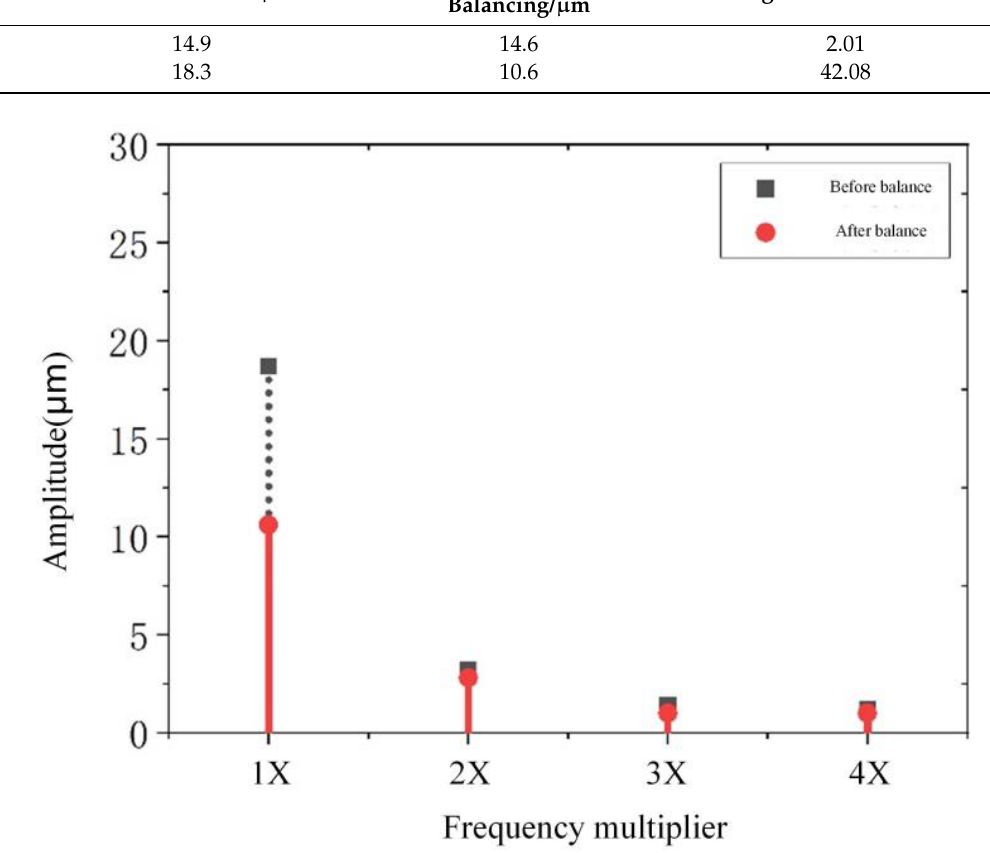
Figure 20. Variation of vibration multiplier frequency at 2# bearing.